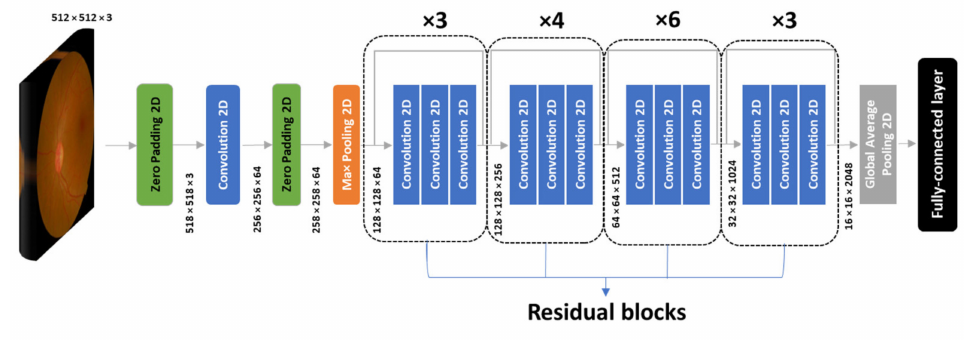
Figure 6. Architecture of ResNet50